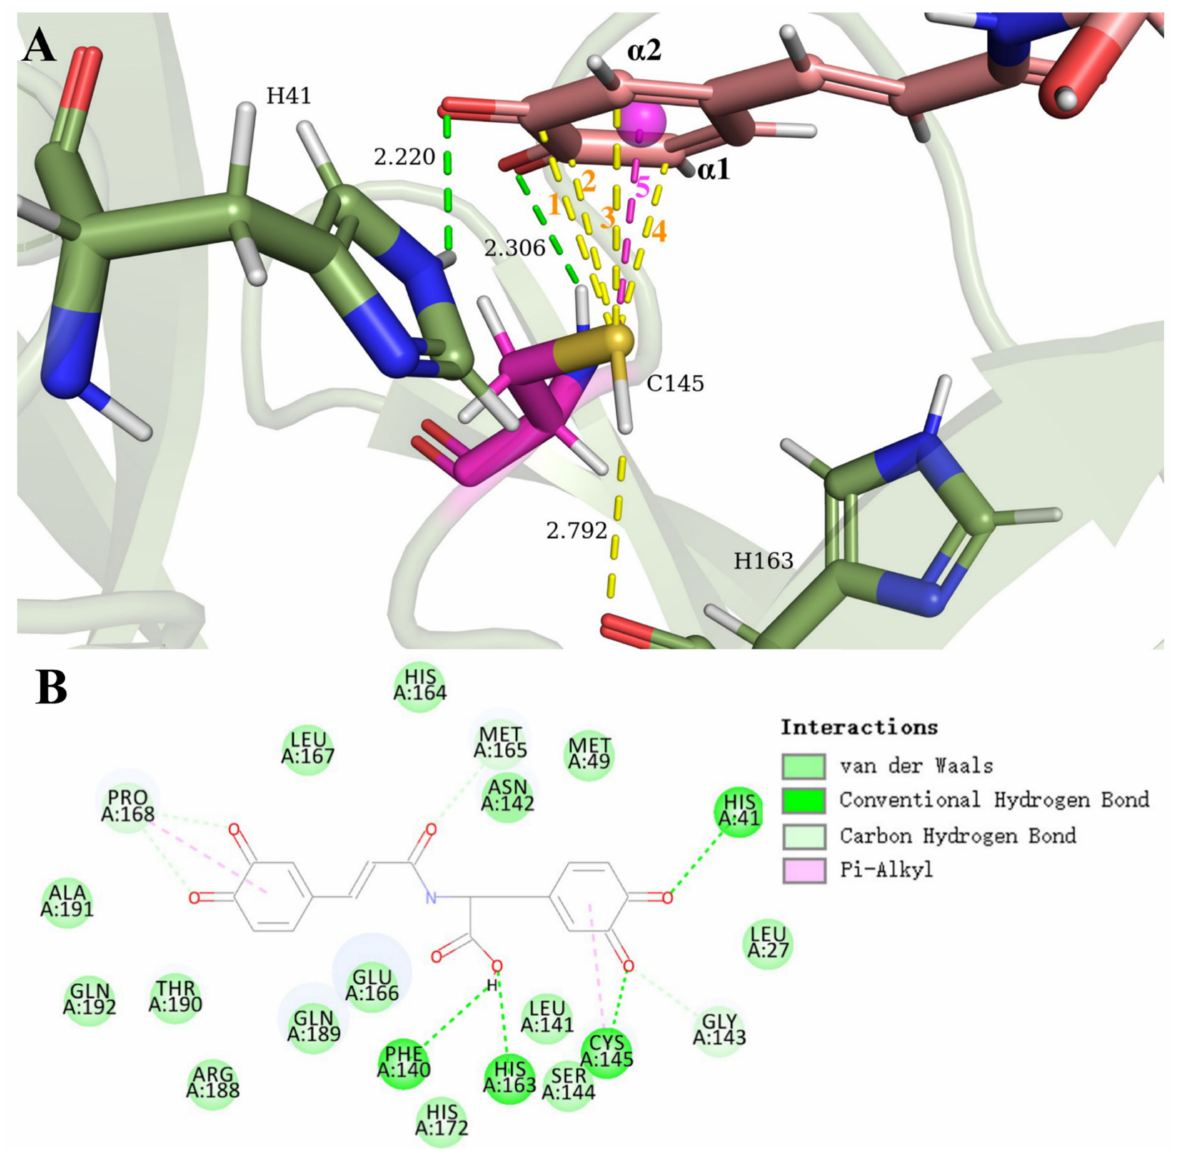
Figure 6. ( A ) Docking pose 15 of clovamide quinone derivative C to M pro . S(C145) points to the ortho-quinone centroid with a very close distance of 2.997 Å. The distances between S(C145) and the electrophilic carbons are as follows: 1 : to the C(C=O) meta to the R group, 3.217 Å; 2 : to the C(C=O) para to the R group, 3.098 Å; 3 : to the top α carbon ( α 2), 3.435 Å; 4 : to the bottom α carbon ( α 1), 3.235 Å; 5: to the centroid of the ortho-quinone ring, 2.997 Å. Green dash lines indicate hydrogen bonds. ( B ) Two-dimensional display of non-covalent interactions between M pro and clovamide quinone derivative C that stabilizes the inhibitor–protease